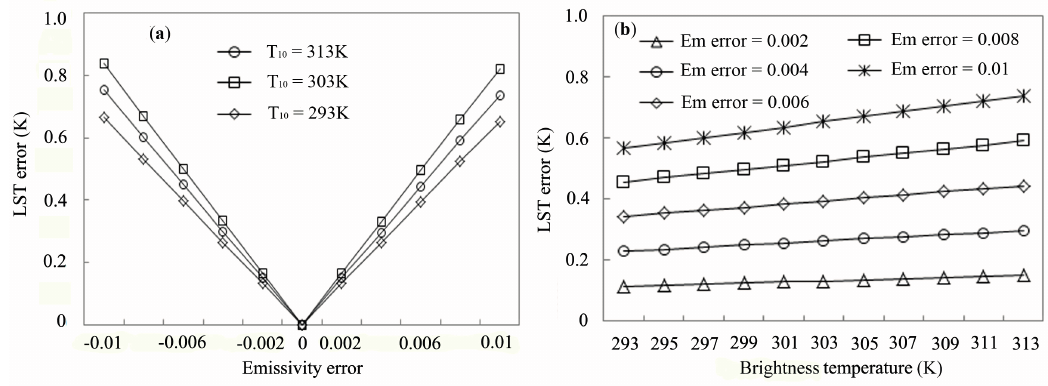
Figure 3. Probable LST estimation error of the improved mono-window IMW algorithm due to the possible error in emissivity estimation. ( a ) Average LST error against possible emissivity error in Band 10; ( b ) possible LST error against Band 10 brightness temperature for different emissivity errors of Landsat 8 TIRS